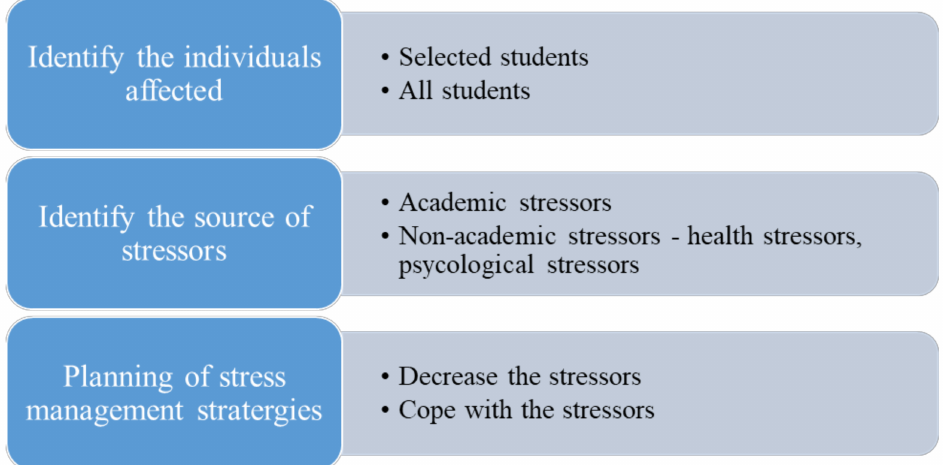
Figure 2. Coping/management strategies for dental